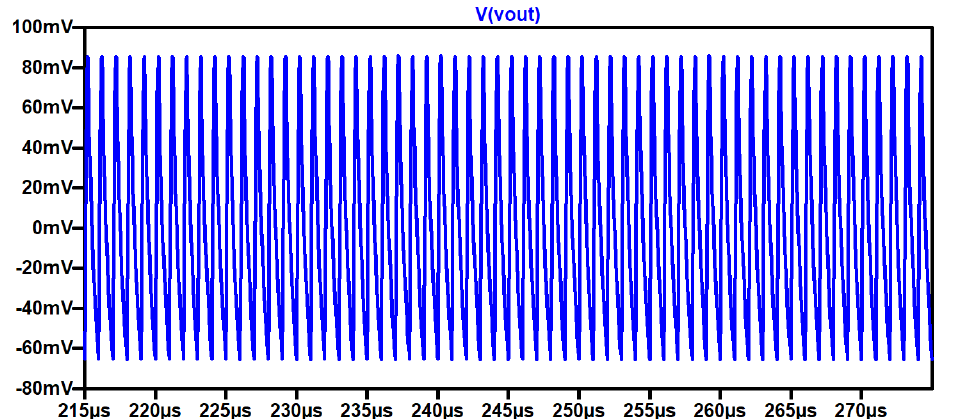
Figure 9. The output voltage response of circuit with Si MOSFET as switch and resistive load configuration.